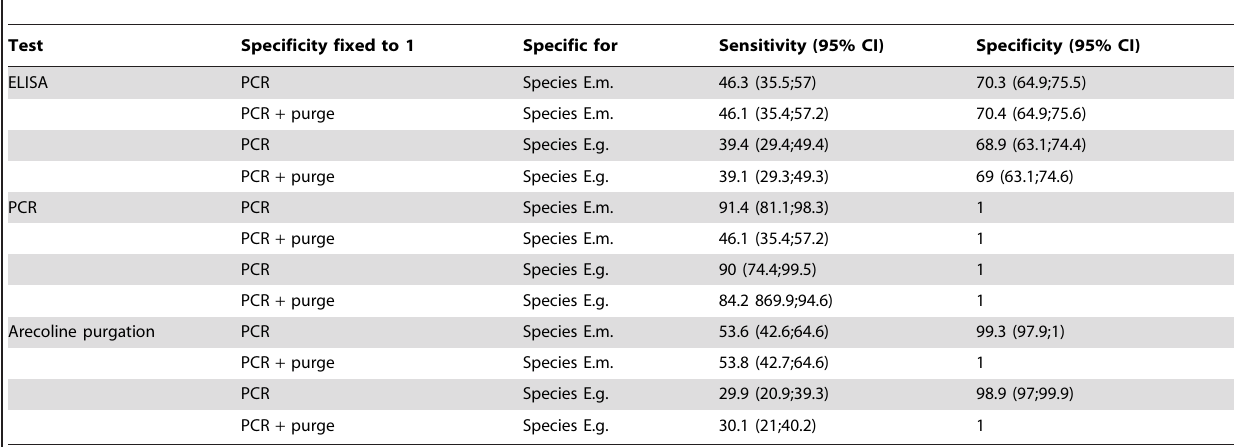
Table 3. Estimated test accuracies with specificities of copro-PCR alone or with purge fixed to 1.